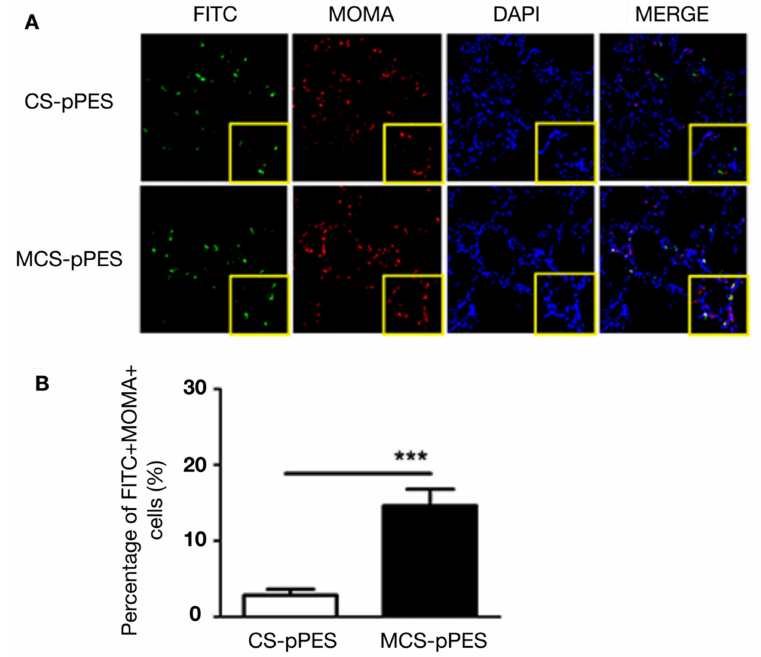
Figure 4. Mannosylation of chitosan nanoparticles (MCS NPs) resulting in enhanced alveolar macrophage targeting for delivery of tuberculosis DNA vaccine compared to regular CS NPs. ( A ) Fluorescent confocal microscopy images of immunized mice lung cross-sections indicating increased uptake of DNA (FITC + , green) within macrophages (MOMA + , red) of MCS NPs compared to CS NPs. ( B ) Quantification of transfection e ffi ciency of DNA NPs (FITC + , green) in alveolar macrophages (MOMA + , red), calculated as a percentage of FITC + MOMA + cells compared to all MOMA +